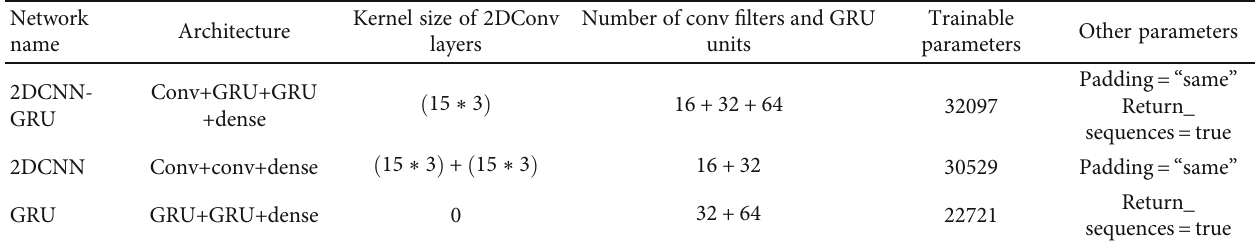
Table 1: The structures of the 2DCNN-GRU, GRU, and 2DCNN.